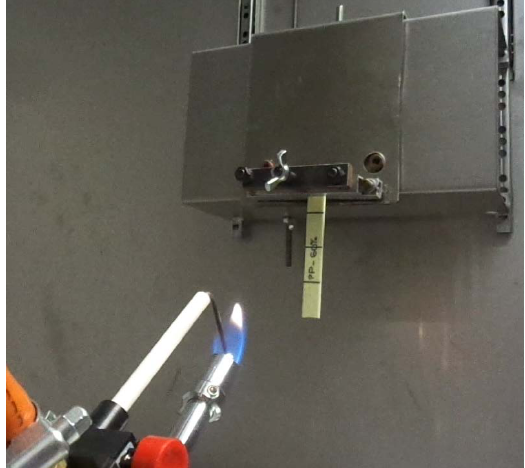
Figure 4: Fire test